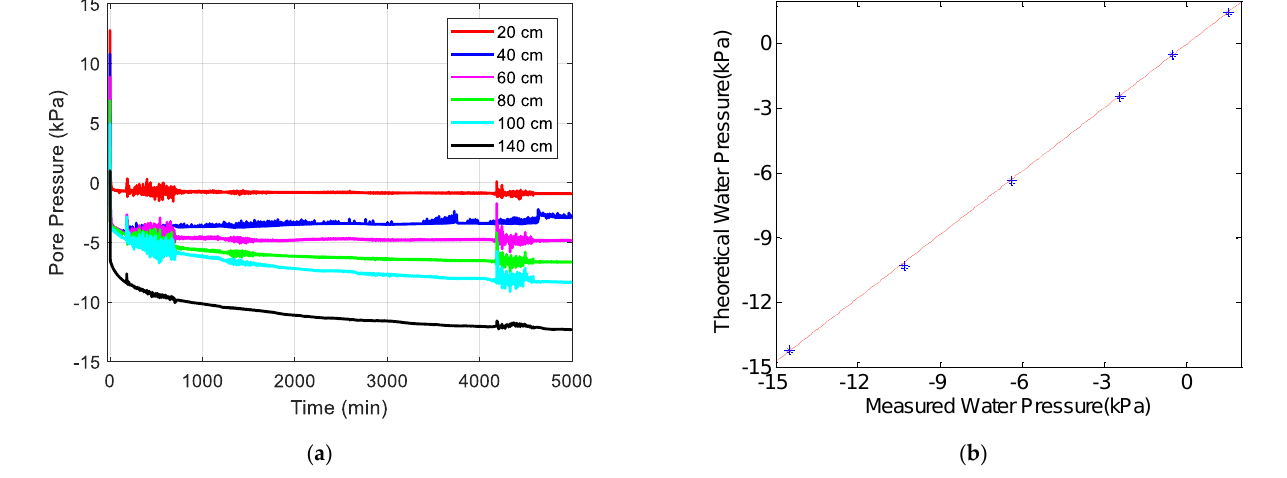
Figure 10. The output from the logging system with the T5 sensors: ( a ) the nonequilibrium and equilibrium soil suction measured by T5 tensiometers; ( b ) the validation of measured pore water pressure against theoretical water pressure above groundwater table.